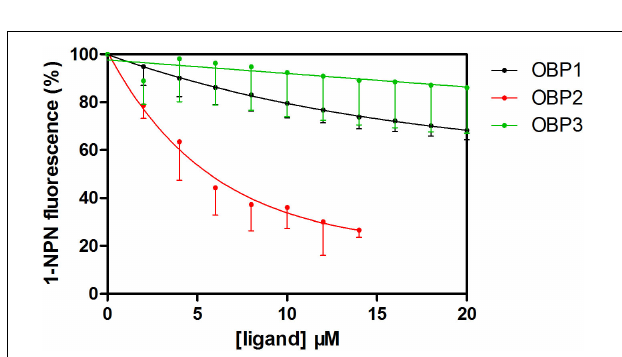
FIGURE 6 | Competitive fluorescence binding of Trissolcus japonicus OBPs and ( E )-2-decenal with 1-NPN.